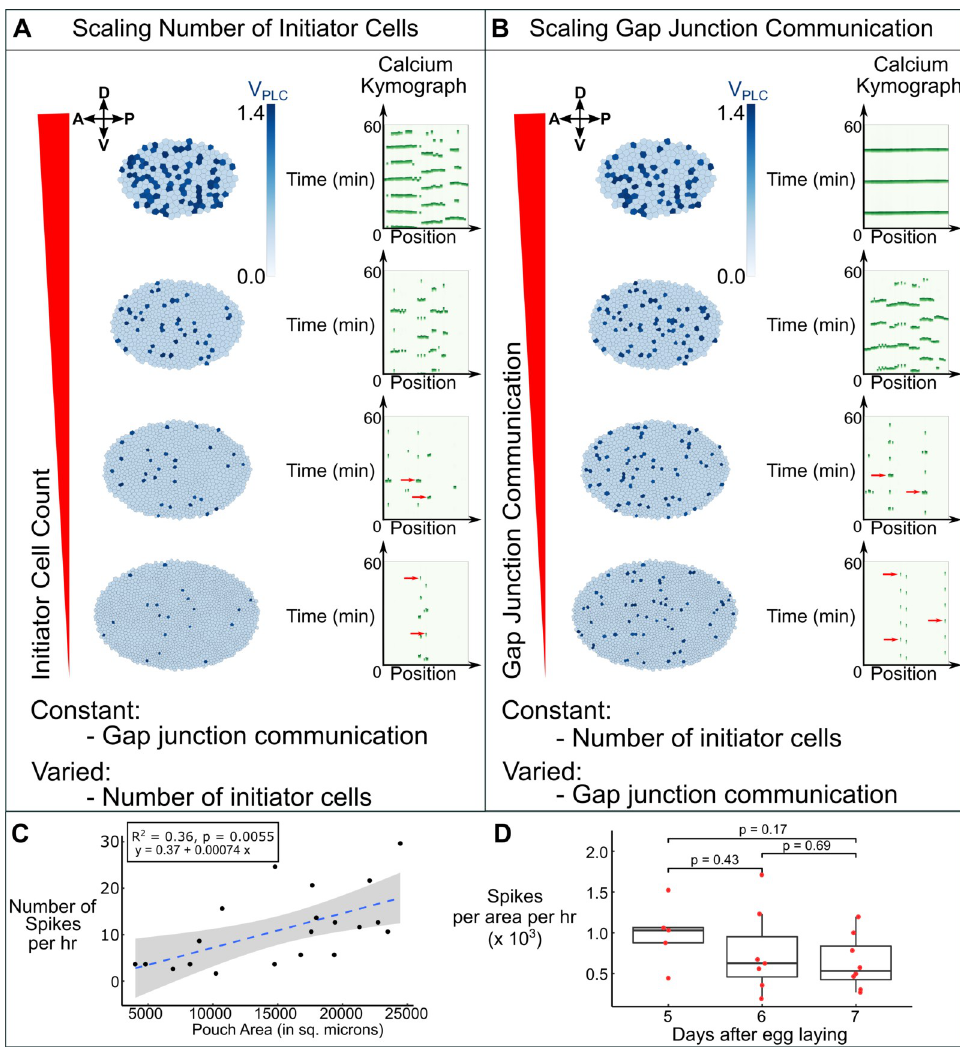
Fig 4. GJ permeability determines total tissue-level signaling activity as development progresses. (A-B) Simulations of Ca 2+ signaling for wing discs of increasing size. (A) (Left column) The total number of initiator cells was varied with tissue size according to the following equation: N ¼ 8 ; 000 � N (cid:0) 0 : 8 while GJ permeability was held constant. The initiators cells V PLC of all standby cells was restricted to values of 0.40, with initiator cells being denoted by dark blue cells with V PLC values between 1.3 and 1.5. (Right column) Associated 2D kymographs of the simulated pouches shown in A . (B) (Left column) The GJ permeability is varied while holding the total number of initiator cells constant. GJ permeability was varied according to the following equation: F constant in this scenario ( N initiator = 65) and standby cells were restricted to V PLC values of 0.40. (Right column) Associated kymographs of the simulated pouches shown in B . Both scaling models demonstrate high Ca 2+ signaling activity in small discs and gradually regress to low Ca 2+ signaling activity in large discs. (C-D) Experimental validation of the computational predictions in which the discs were cultured ex vivo in Grace’s low 20E media (basal media) for 1 h in the absence of any stimulus triggering Ca 2+ . (C) Quantification of total number of Ca 2+ spikes in different sized wing disc pouch during 1 h culture. A linear regression line was fit to the data set and the p-value for the slope of the fitted line is shown. Since the p- value is less than 0.05 (level of significance), a positive correlation between size and the number of spikes could be inferred. Grey region corresponds to 95% confidence bands of the trend line. (D) Quantification of total number of spikes in disc pouch scaled with respect to pouch size during various stages of larval development. p -values were obtained by Mann Whitney U test.